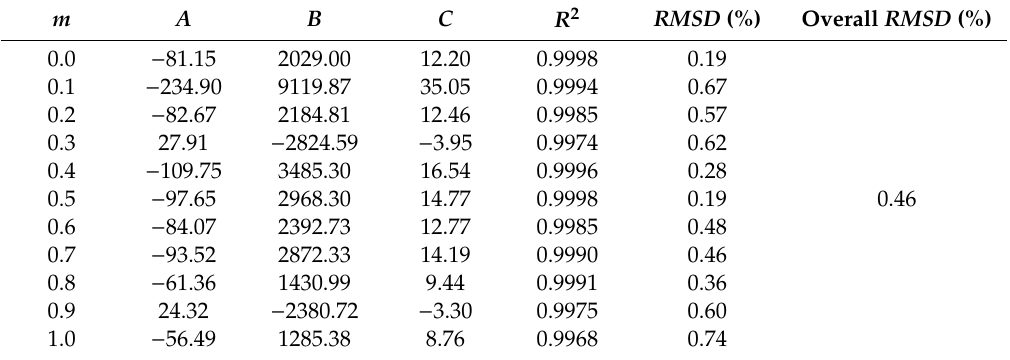
Table 6. The parameters of “Apelblat model ( A, B and C )” along with R 2 and % RMSD s for ECT in various “PEG-400 + water” combinations ( m ) d